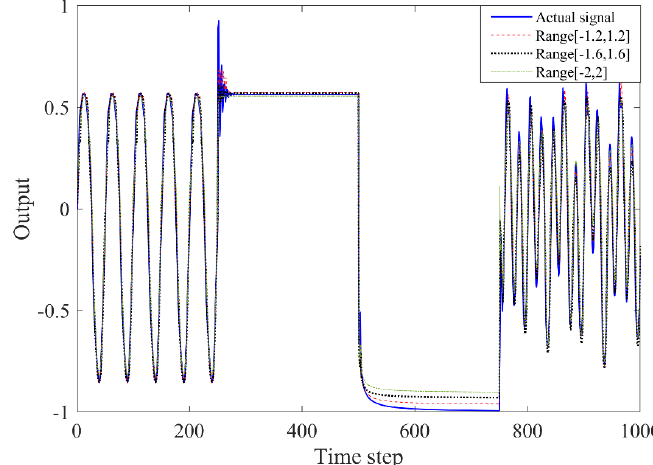
Figure 6. The identification results for a dynamic system using the STFCMAC model with different training magnitude regions.